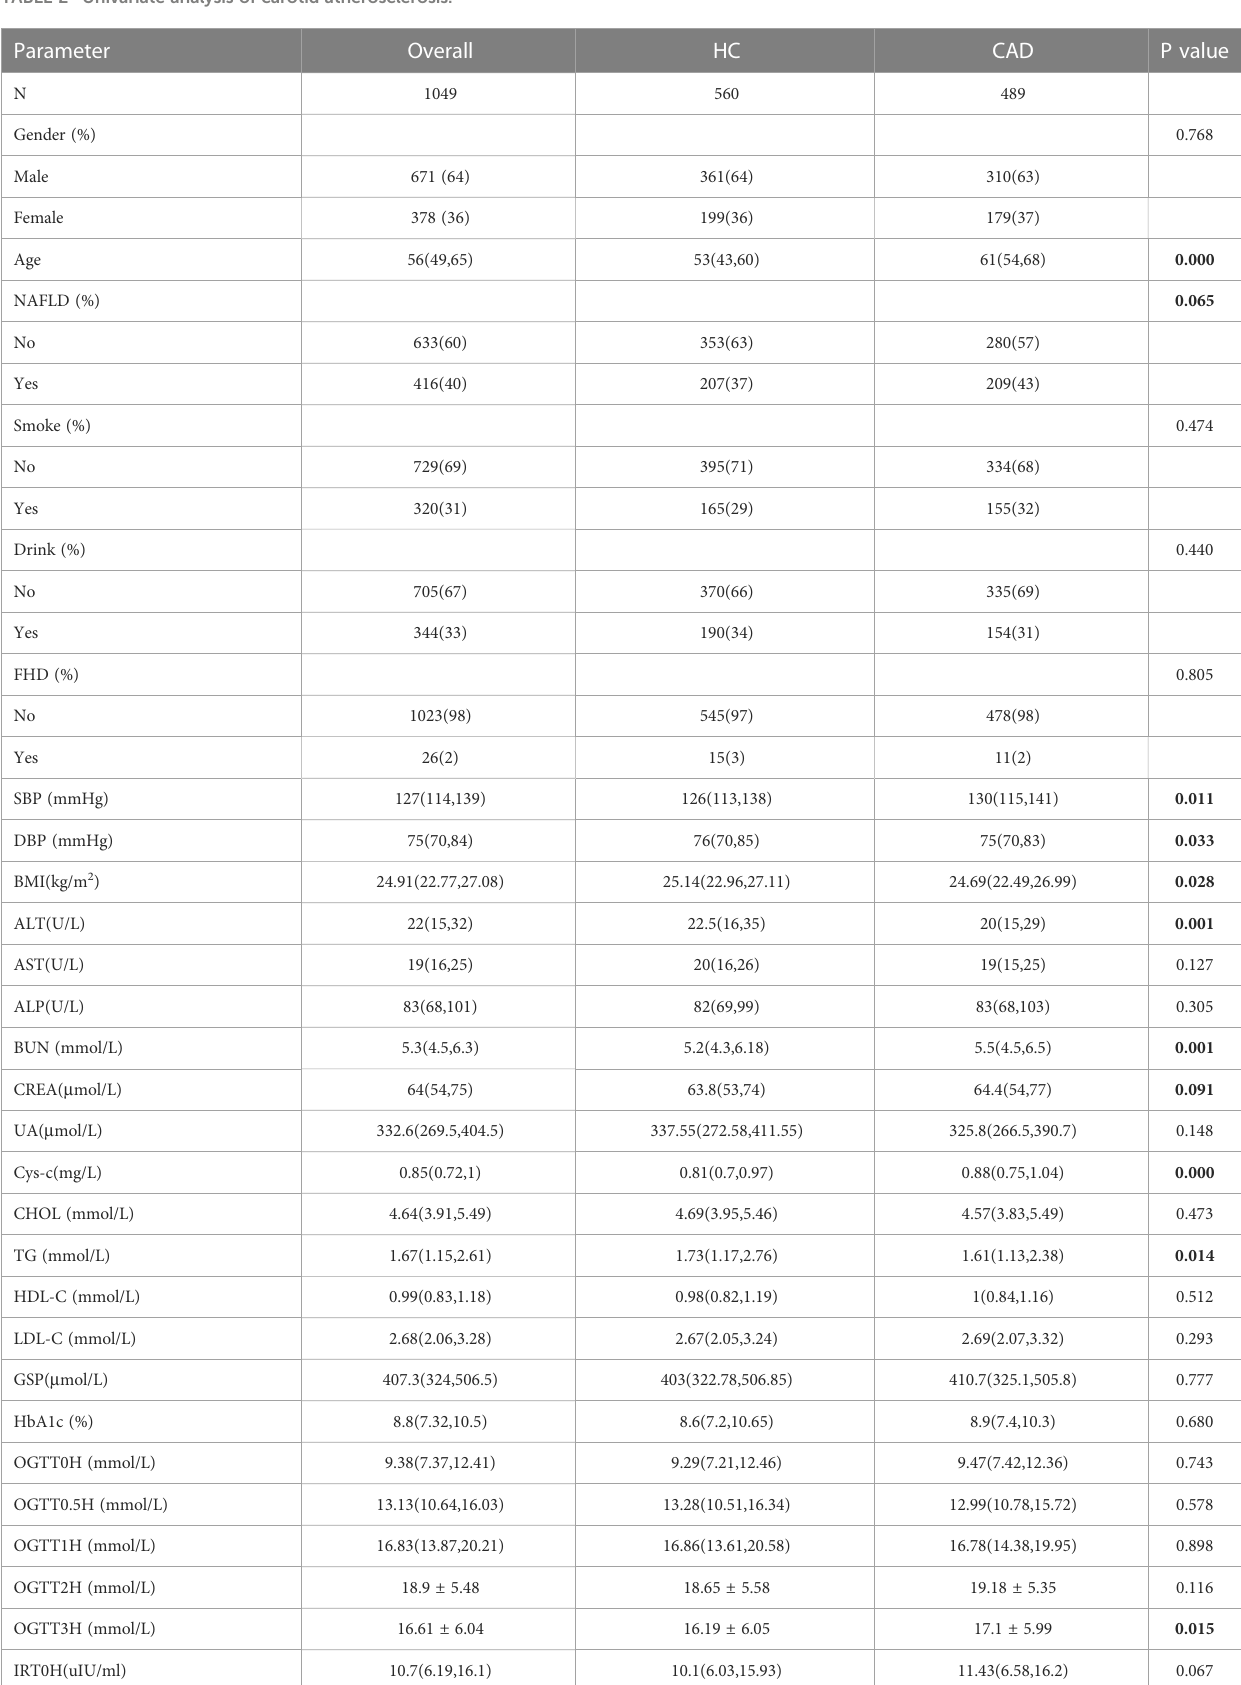
TABLE 2 Univariate analysis of carotid